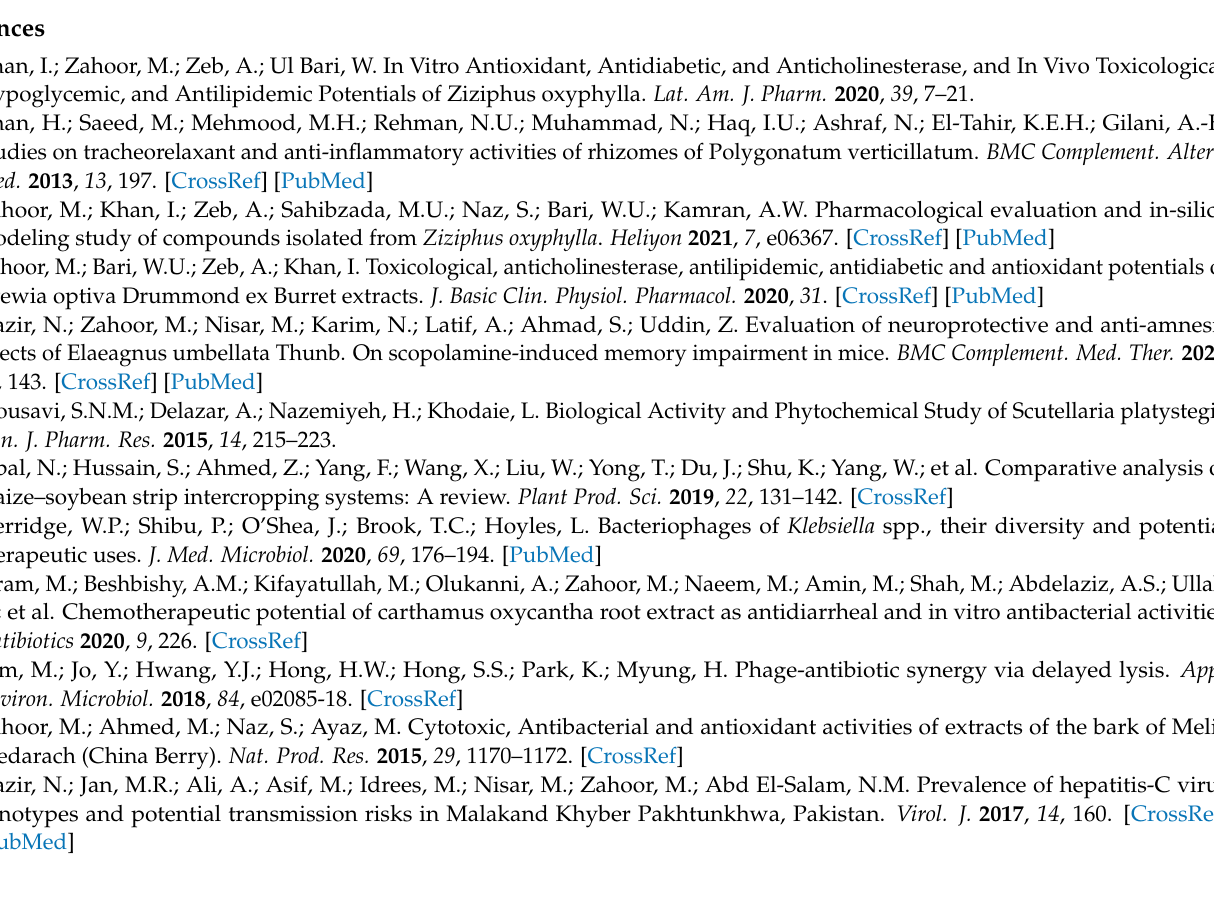
Figure S18: ESI-HRMS of TA, Figure S19: 1 H-NMR of compound FL-1, Figure S20: 13 C-NMR of compound FL-1, Figure S21: ESI-HRMS of FL-1 , Figure S22: 1 H-NMR of compound FL-2, Figure S23: 13 C-NMR of compound FL-2, Figure S24: ESI-HRMS of FL-2 , Figure S25: 1 H-NMR of compound FL-3, Figure S26: 13 C-NMR of compound FL-3, and Figure S27: ESI-HRMS of